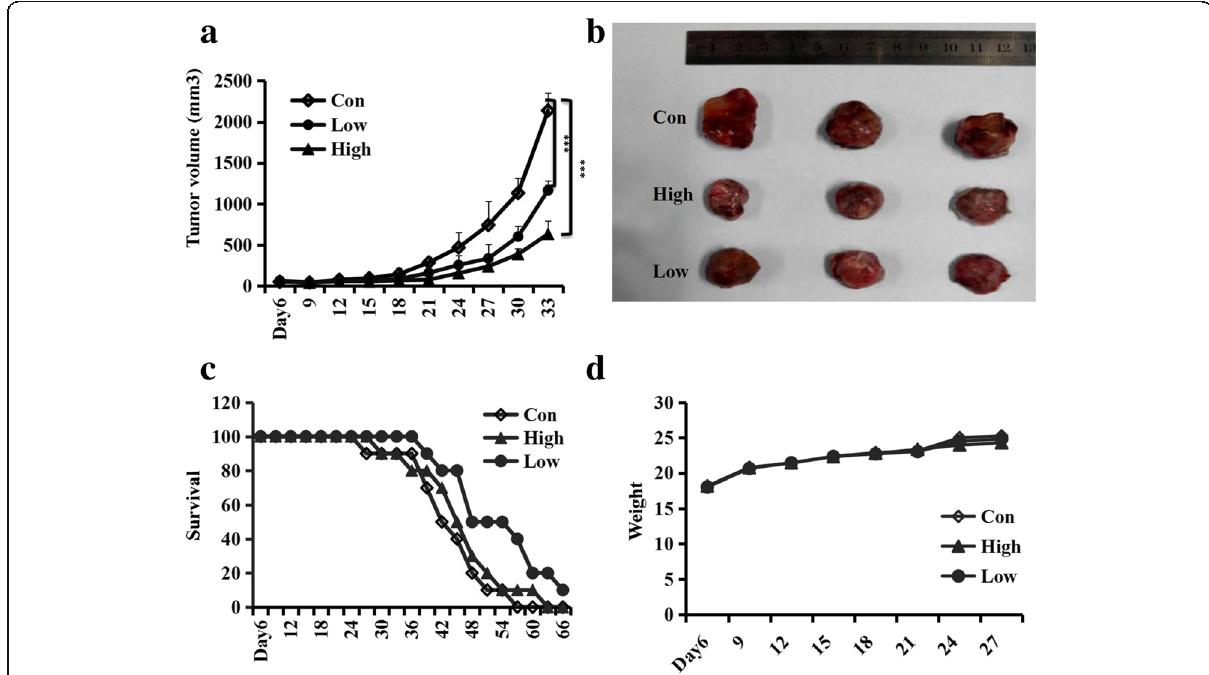
Fig. 5 Coptis Chinensis inhibited Glioma tumor growth. U87 cells (3 × 10 6 ) were subcutaneously injected into the right axilla of Balb/c nude mice. Two days after injecting, Coptis Chinensis (20 and 10 mg/per mouse/day, respectively and distilled water per mouse was administered intragastrically. a , b Tumor volume and tumor photos at different time and various concentrations points. c , d Survival and weight at different days. Data are presented as mean ± SD from three independent experiments. *, P < 0.05; **, P < 0.01; ***, P < 0.001 compared with the control